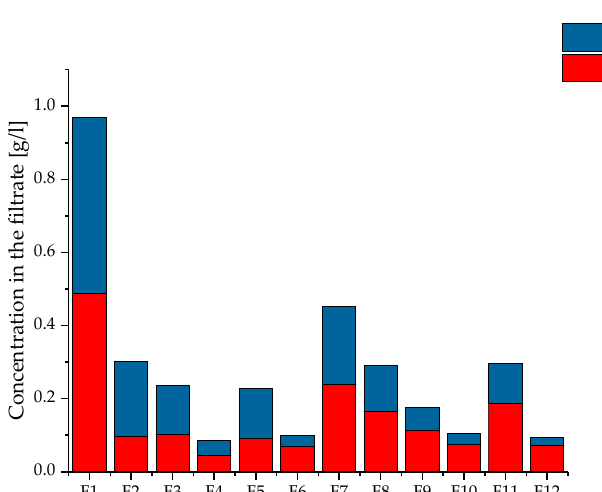
Figure 6. Concentration of cobalt and nickel in the filtrate after precipitation with oxalic acid.